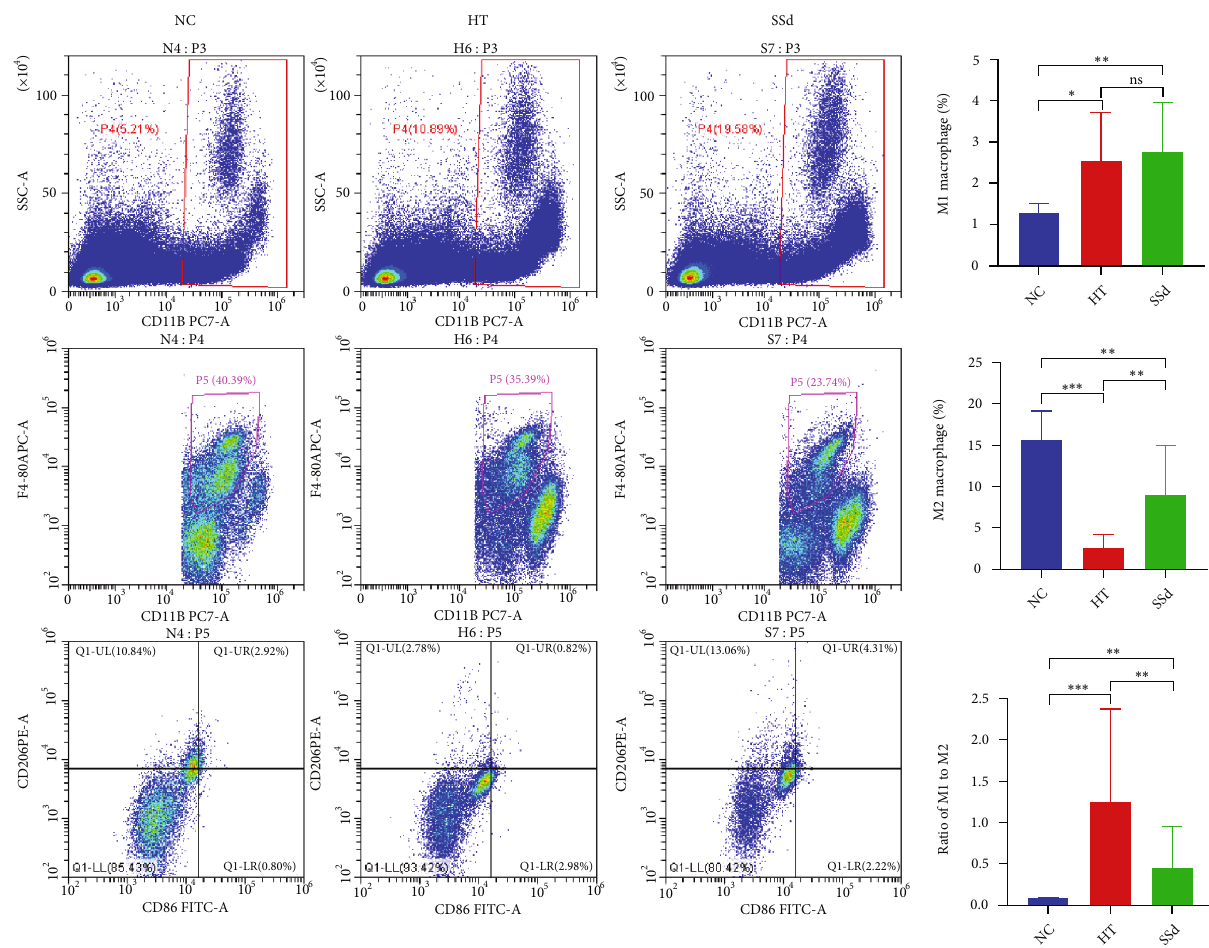
Figure 9: Flow cytometric detection of M1/M2 macrophages in mice spleen ( ∗∗∗ P < 0 : 001 , ∗∗ P < 0 : 01 , ∗ P < 0 : 05 ).